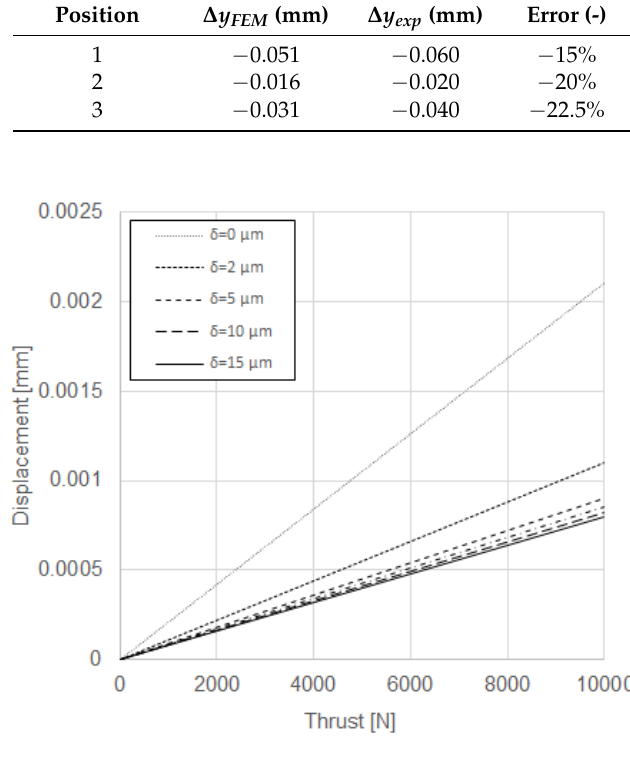
Figure 8. Thrust–displacement diagram of the double-row angular contact roller bearing, supplied by the manufacturer.